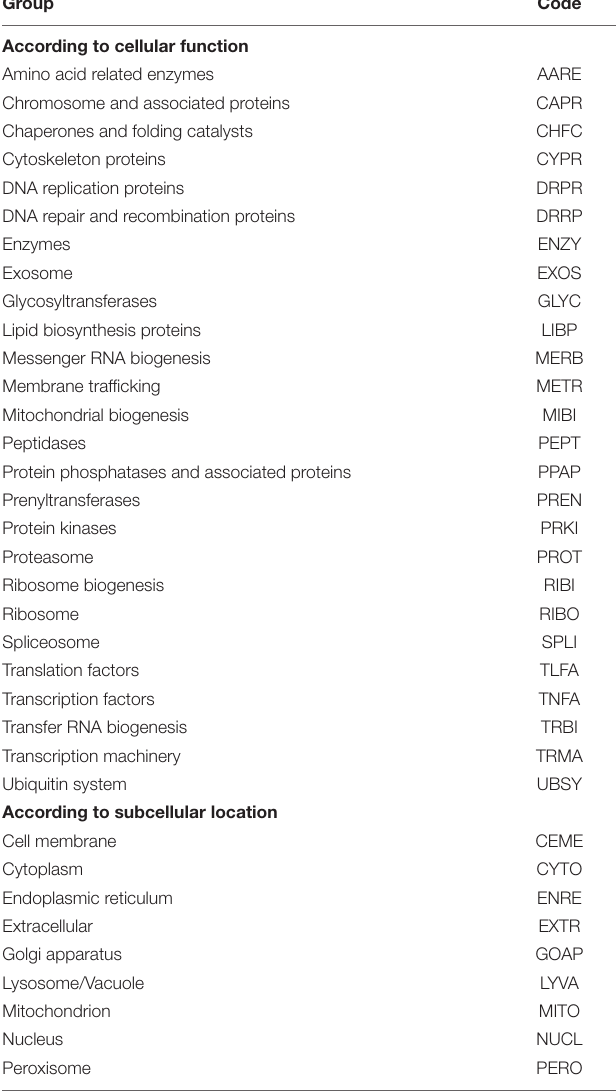
TABLE 1 | Codes used for groups of